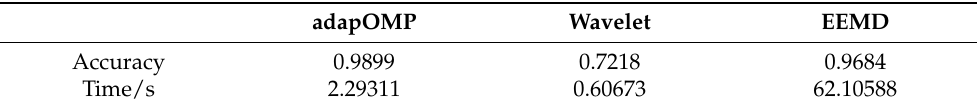
Table 1. Performance of different methods to extract harmonic